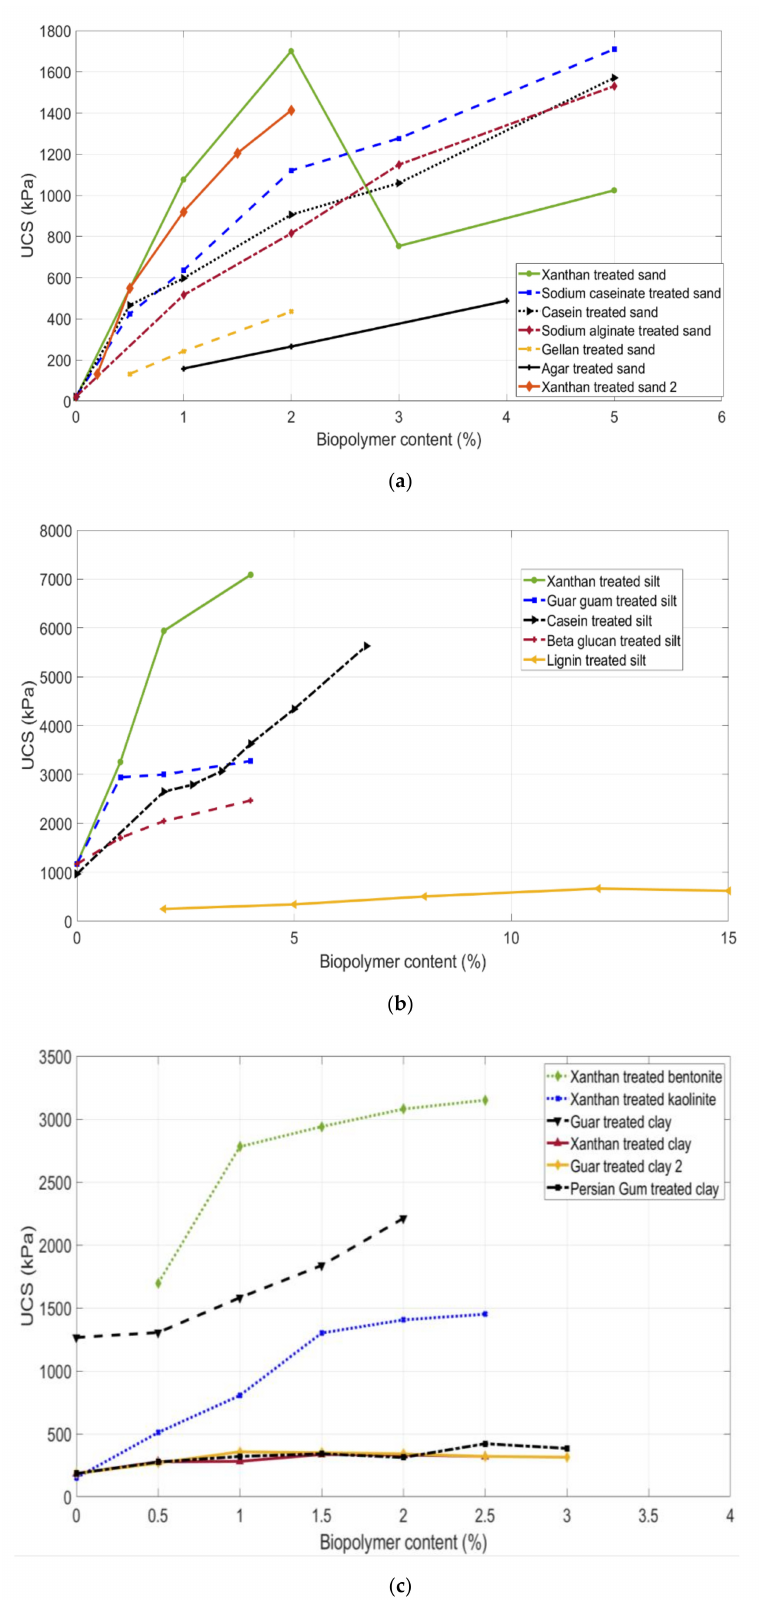
Figure 11. Effect of biopolymer content on compressive strength of soils ( a ) biopolymer-treated sand, ( b ) biopolymer-treated silt, ( c ) biopolymer-treated clay